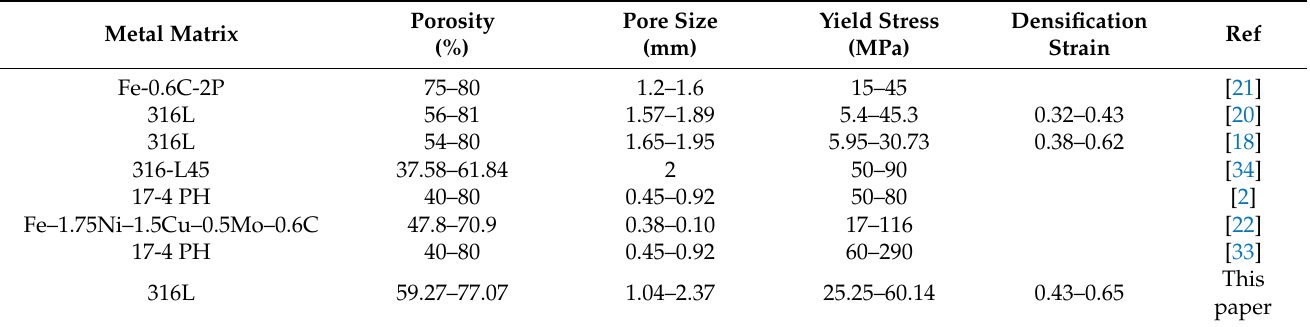
Table 3. Comparison of properties of steel foam under quasi-static loading.